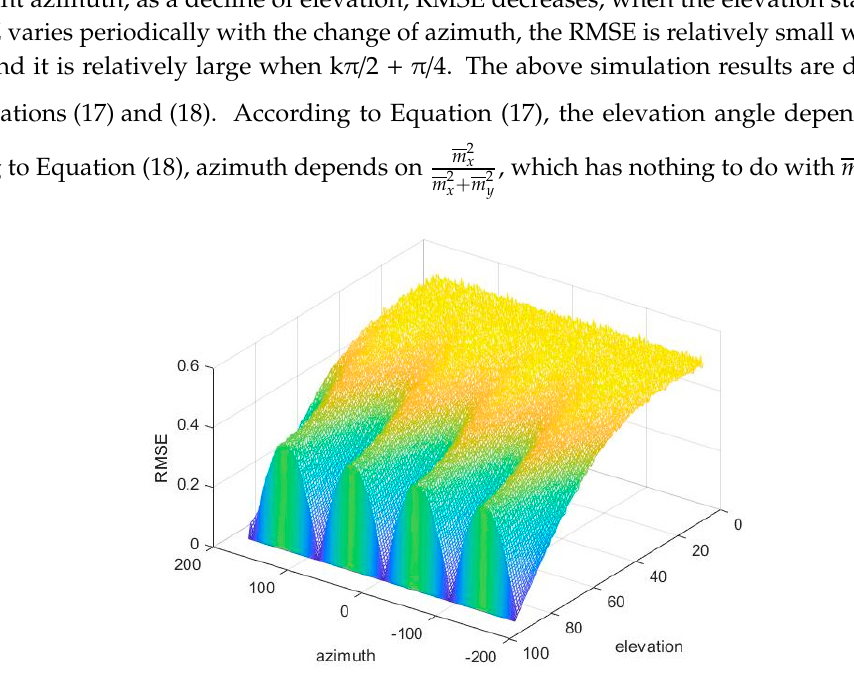
Figure 7. Root mean square error (RMSE) for different DOAs in degrees.